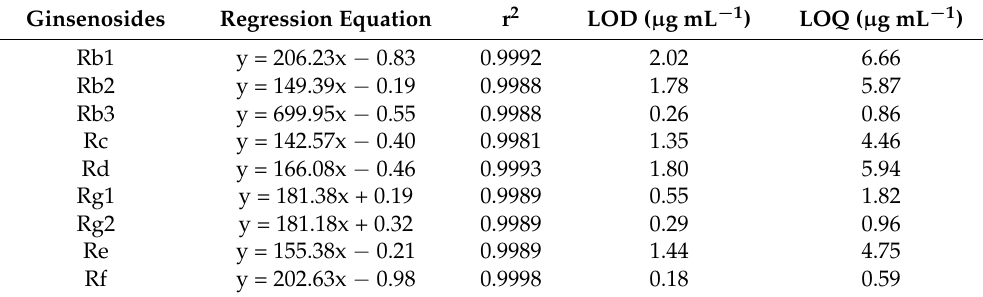
Table 1. The ginsenoside standard